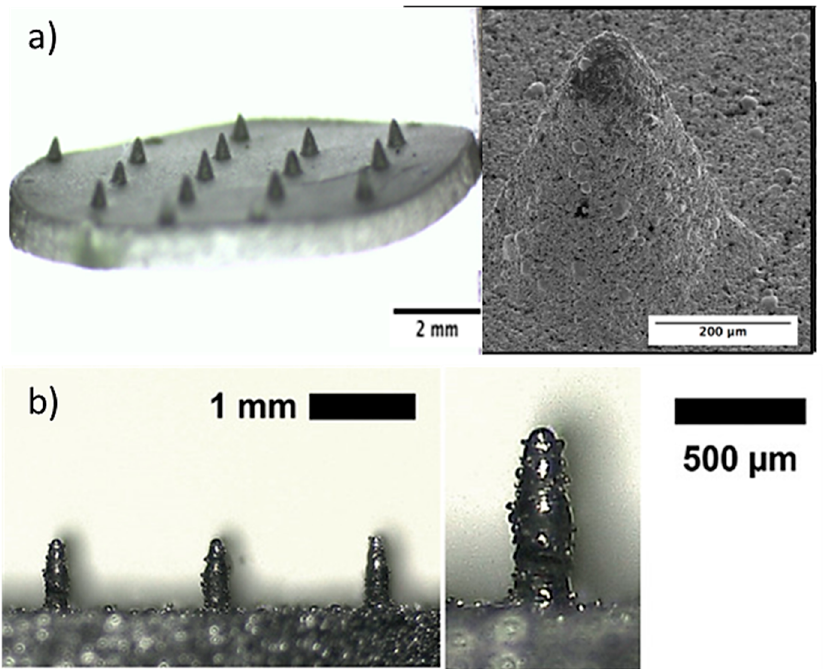
Figure 4. Stainless steel ( a ) porous MNs used for storage, delivery of drugs and absorption of fluids for biosensing produced by the hot embossing technique. Reprinted with permission from Ref. [27]. 2005, Elsevier Science &Technology Journals, ( b ) solid conical–shaped MN electrodes in a rectangular patch produced by direct metal laser sintering (DMLS) 3D printing process. Reprinted with permission from Ref. [104]. 2020, Advanced Materials Technologies.